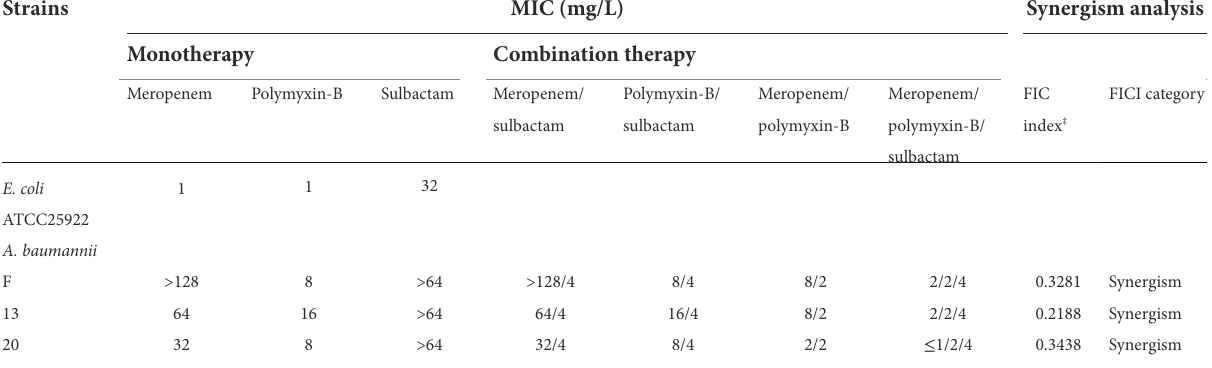
TABLE 2 Minimum inhibitory concentrations of meropenem, polymyxin-B and sulbactam alone or in combination with or without sulbactam (4 mg/L) against carbapenem-resistant Acinetobacter baumannii isolates and fractional inhibitory concentration index (sulbactam was fixed at 4 mg/L). Strains MIC (mg/L)